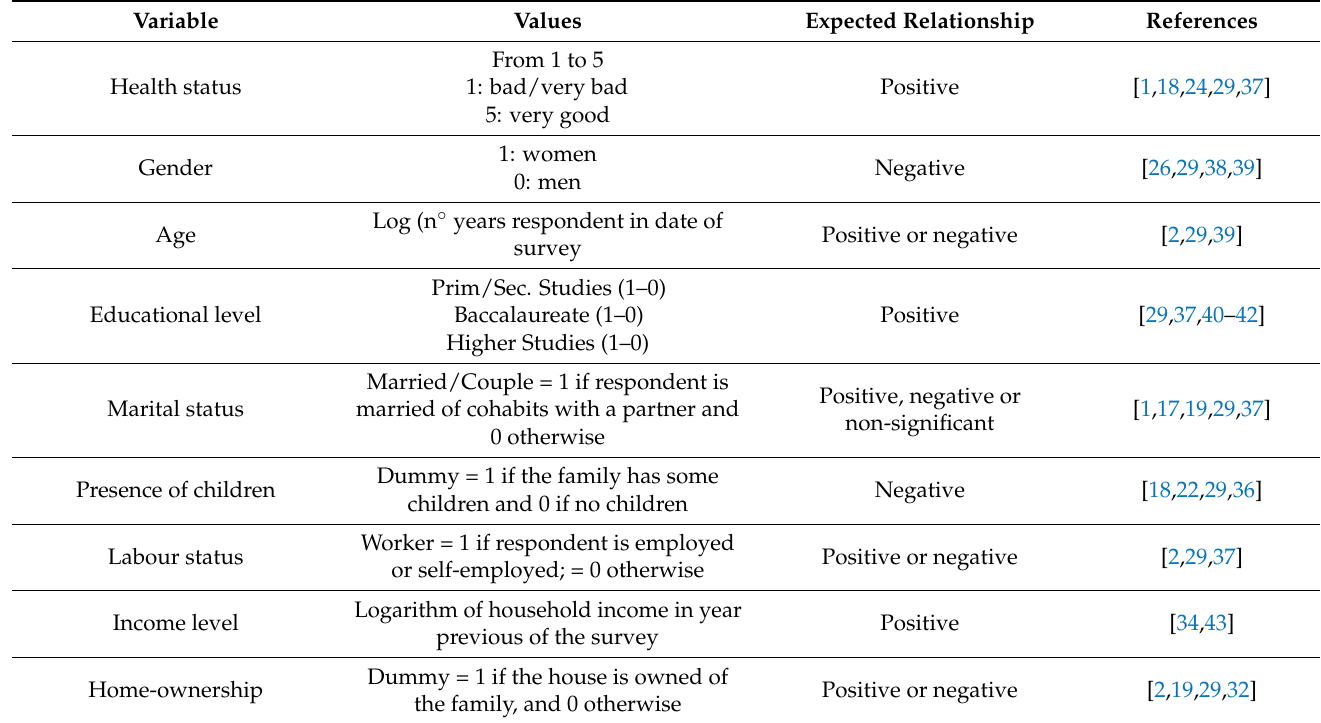
Table 1. A description of the control